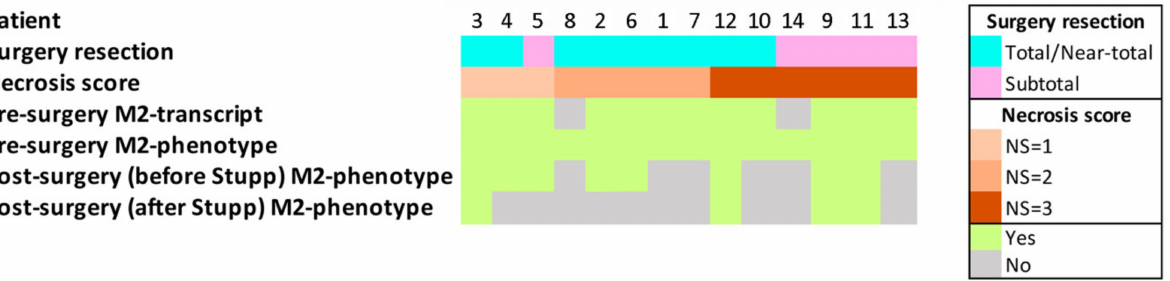
Figure 6. Workflow of the studied GBM